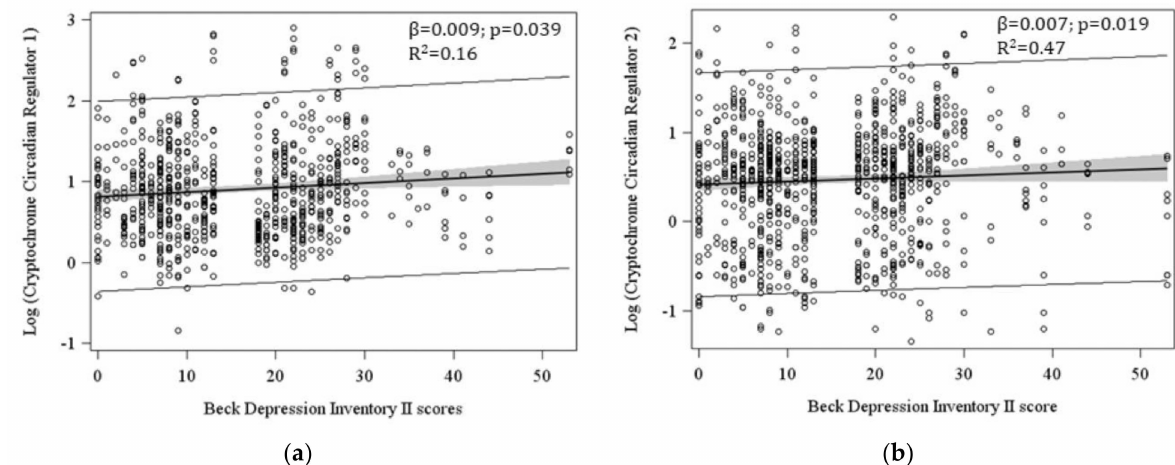
Figure 2. ( a ) The scatterplot reports CRY1 repeated 6 times for each subject as the methylation was measured at 3 CpG dinucleotide positions and 2 measurements; ( b ) The scatterplot reports CRY2 repeated 8 times for each subject as the methylation was measured at 4 CpG dinucleotide positions and 2 measurements. Models were adjusted for Homa-IR index, percentage of neutrophils, homocysteine plasma level, vitamin D deficiency, position of methylation, taking into account repeated measures.